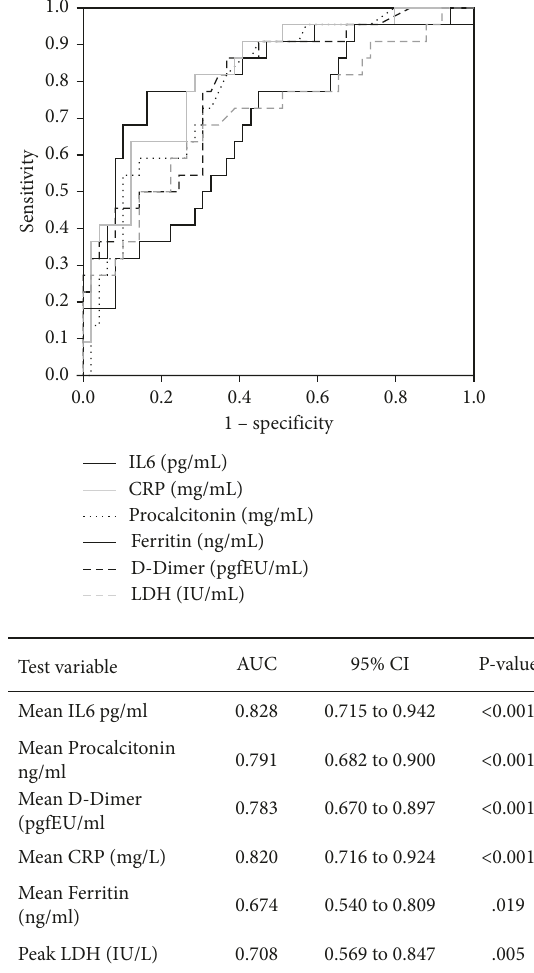
Figure 2: ROC curve and area under the curve (AUC) for bio- markers IL6, Procalcitonin, D-dimer, CRP, Ferritin, and LDH in KTRs with